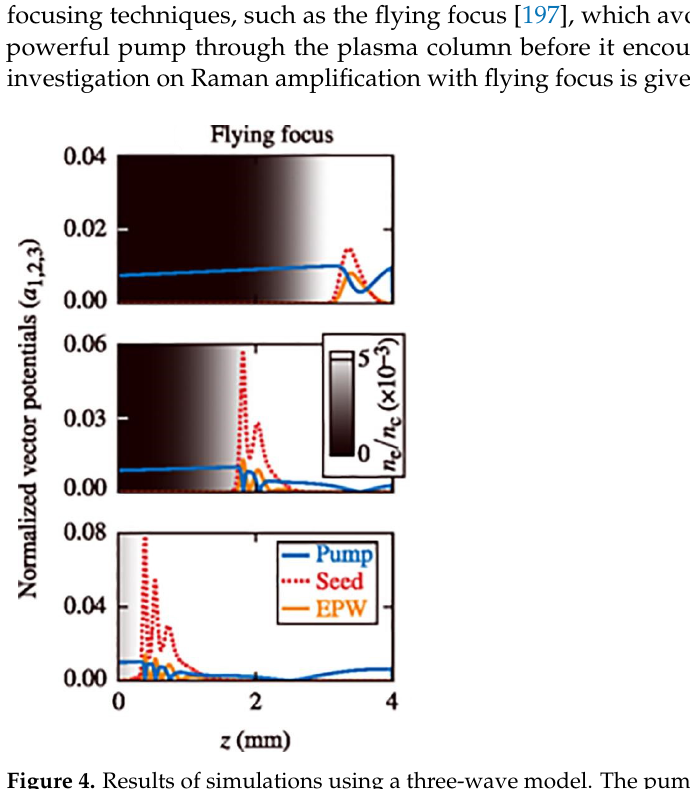
Figure 4. Results of simulations using a three-wave model. The pump first reaches a high intensity with the flying focus at the right edge, when ionisation is initiated. As various colours converge to various locations, constant intensity moves at υ = − c , and as a result, the ionisation wave propagates at a nearly constant distance ahead of the injected seed pulse. We see the ideal plasma amplifier behaviour. This figure was reprinted/adapted with permission from Ref. [197]. Copyright year: 2022, Publisher: American Physical